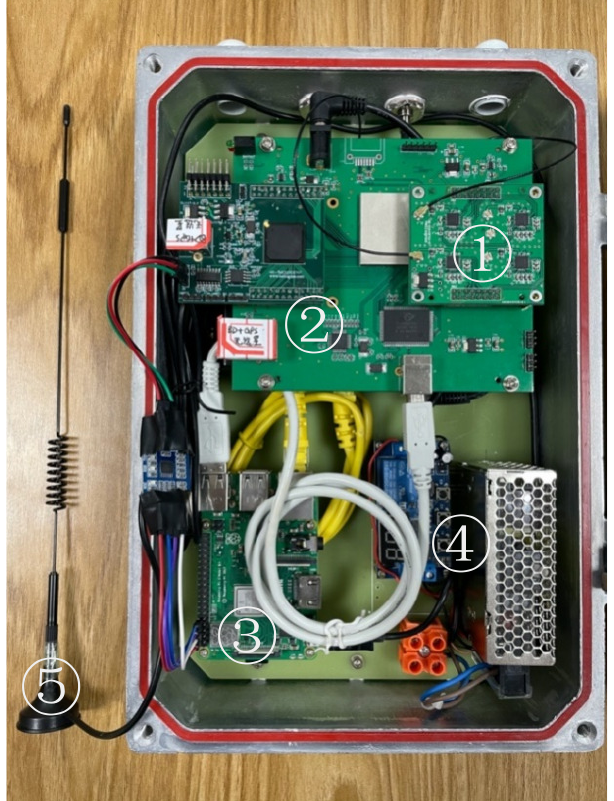
Figure 8. Physical map in the packaged